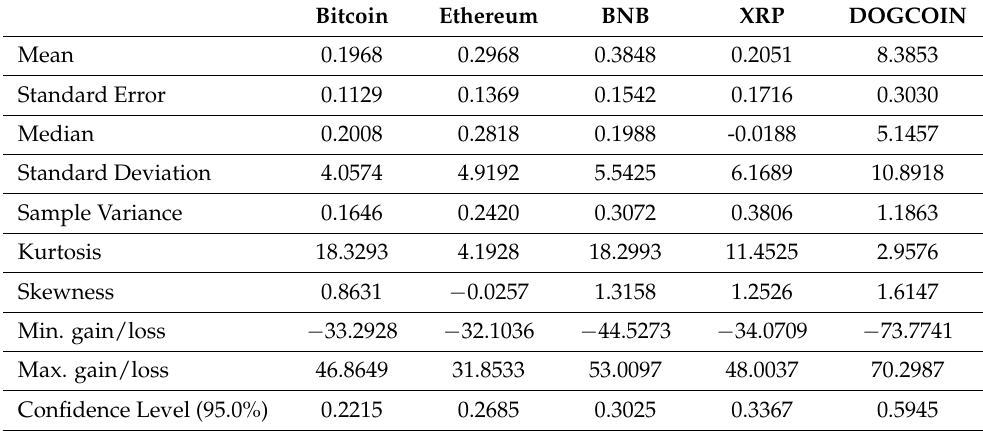
Table 1. Descriptive statistics of daily return of cryptocurrencies